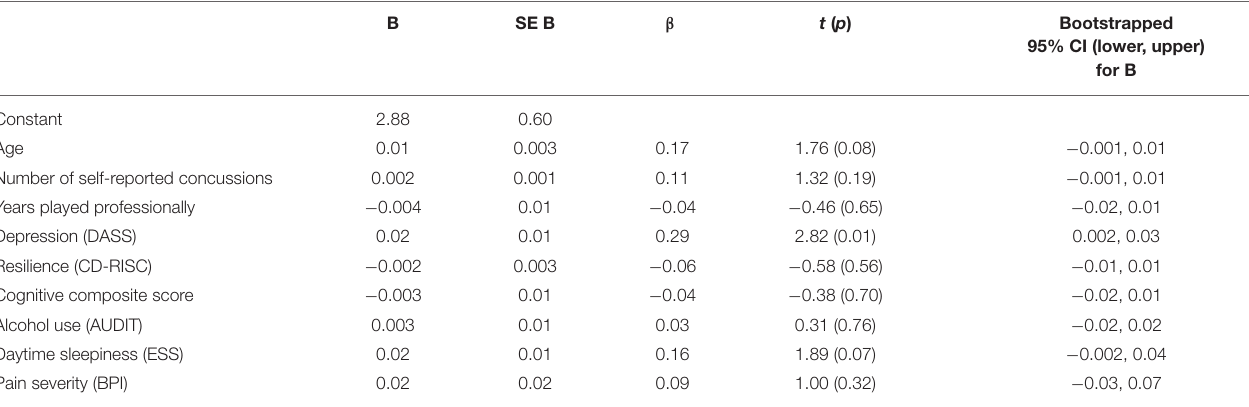
TABLE 6 | Simultaneous multiple regression model with perceived cognitive decline (IQCODE-self) as the outcome.